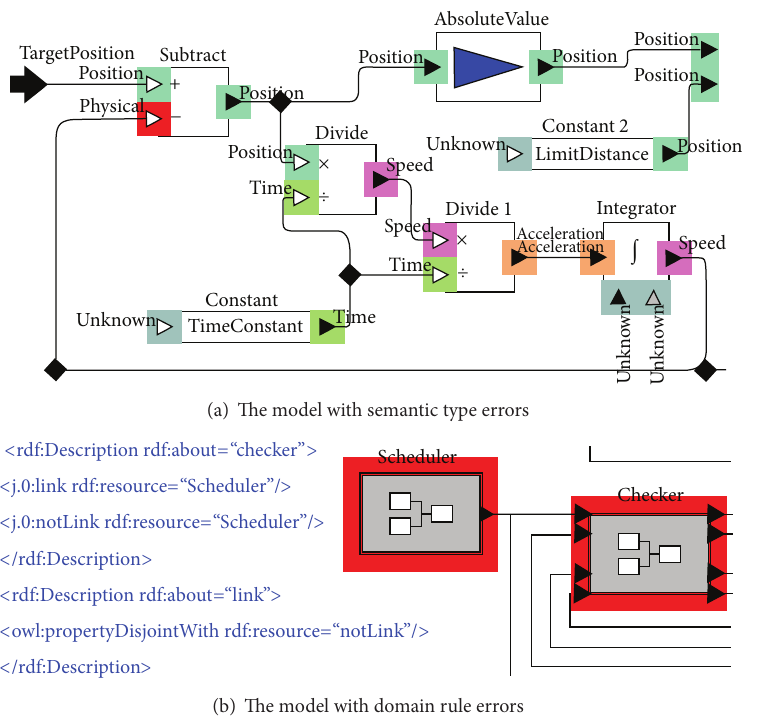
Figure 8: The error models of gate control